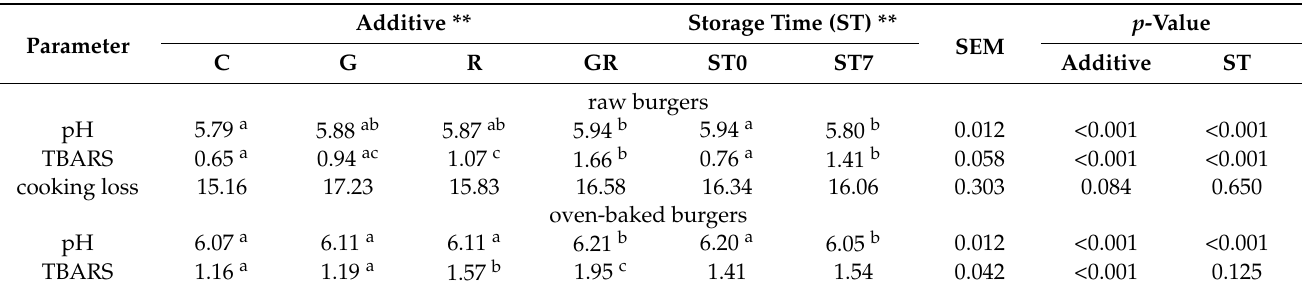
Table 1. pH, TBARS values (mg malondialdehyde/kg meat) and cooking loss (%) of raw and oven-baked burgers (means ±